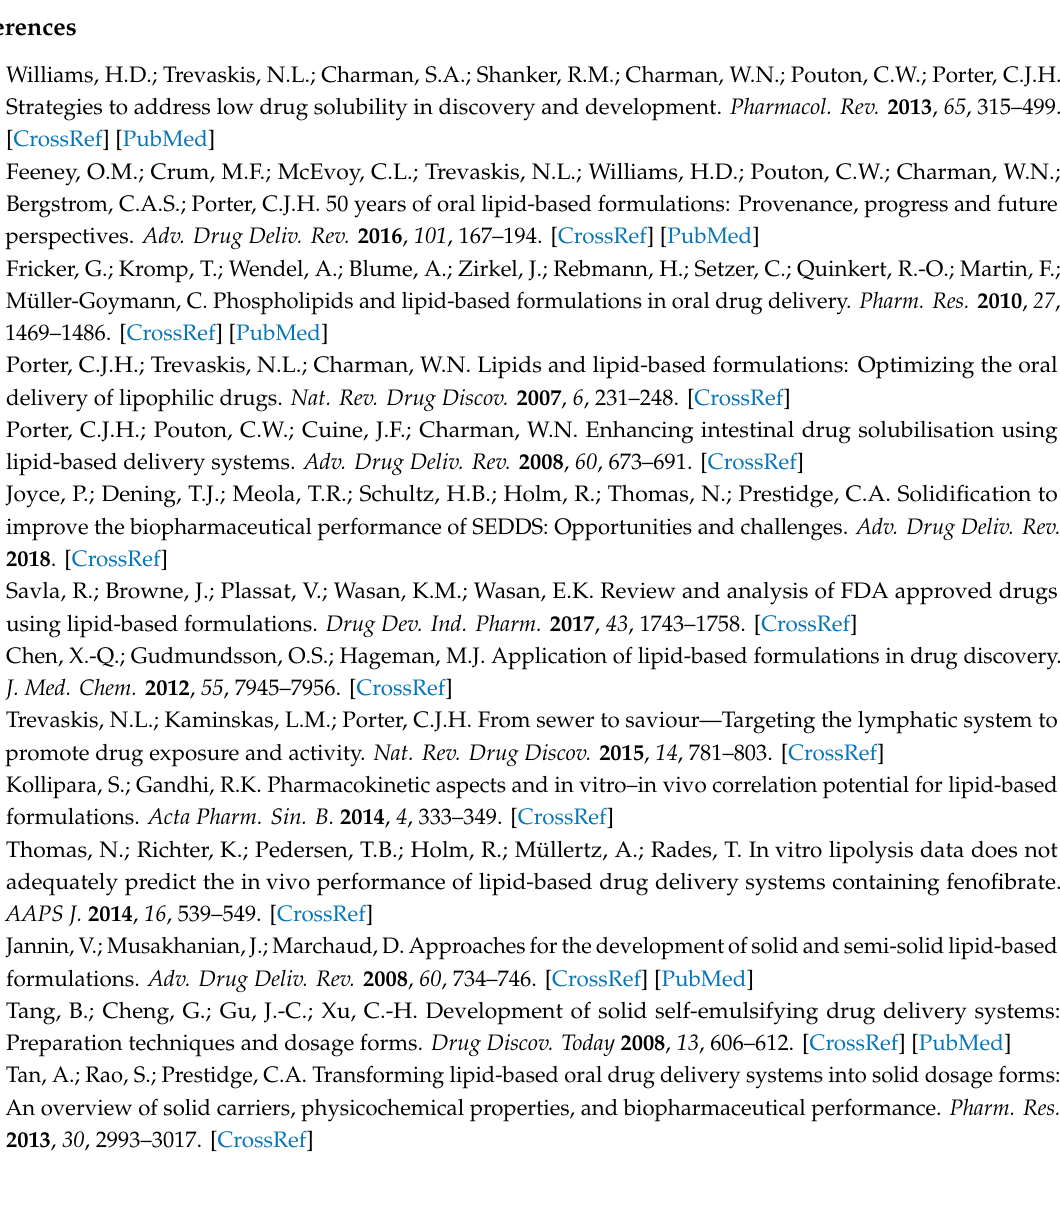
The lipid content of the formulations and lipid dosed to lipolysis vessel. Figure S1. The relationship between XRPD peak intensity at 22.3 ◦ (2 θ ) and supersaturated drug loading (Seq) for FS PG8 formulations and MPS PG8 formulations, Figure S2. The % phase partitioning of FEN between the aqueous phase and pellet over 90 min after a 3 mg FEN dose of 80% formulations, Crystalline FEN and APO-fenofibrate, under biorelevant gastric and intestinal conditions. Values represent mean ± SD, n = 3 and Figure S3. The % phase partitioning of FEN between the aqueous phase and pellet over 90 min after a 3 mg FEN dose of supersaturated formulations, under biorelevant gastric and intestinal conditions. Values represent mean ± SD, n =